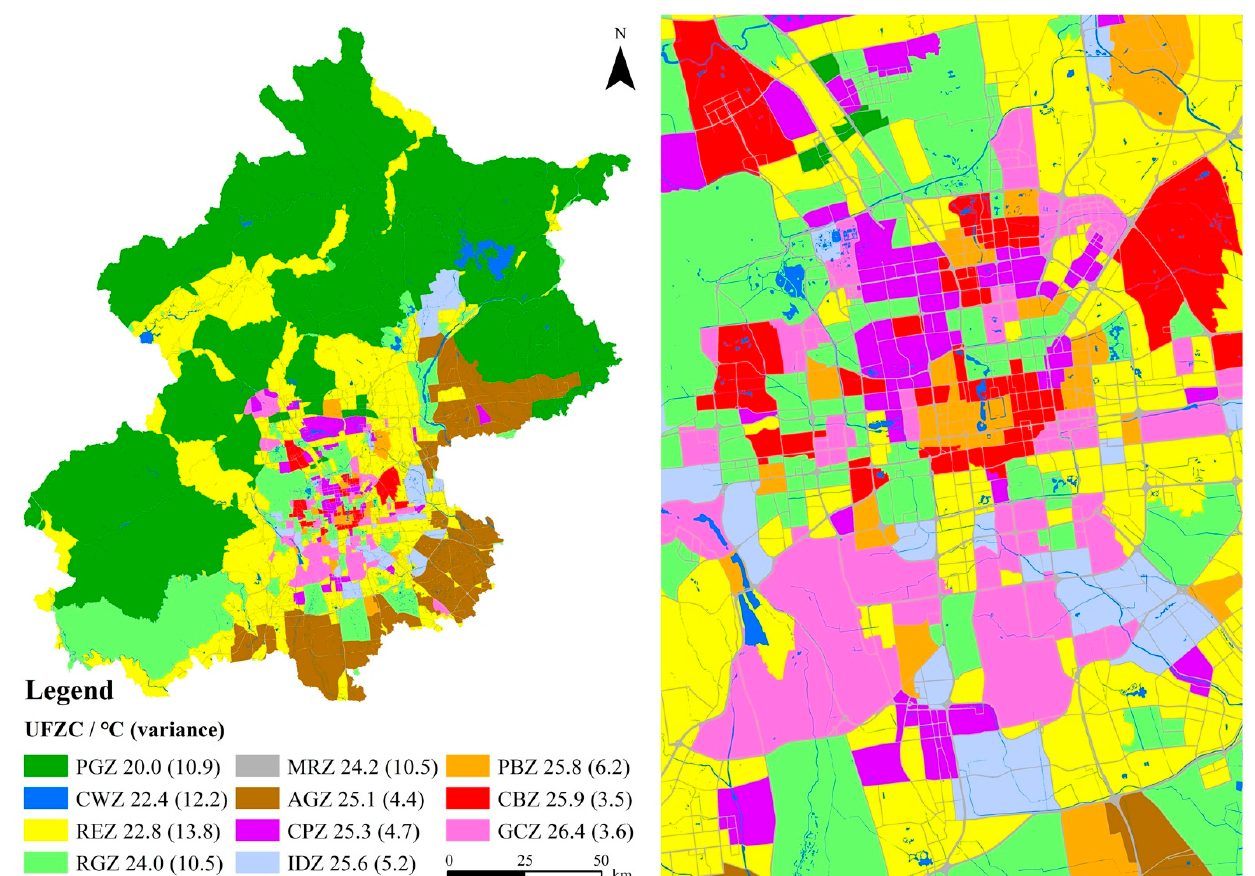
Figure 6. The UFZC result of Beijing ( left ) and an enlarged view inside the 5th ring-road of Beijing ( right ).